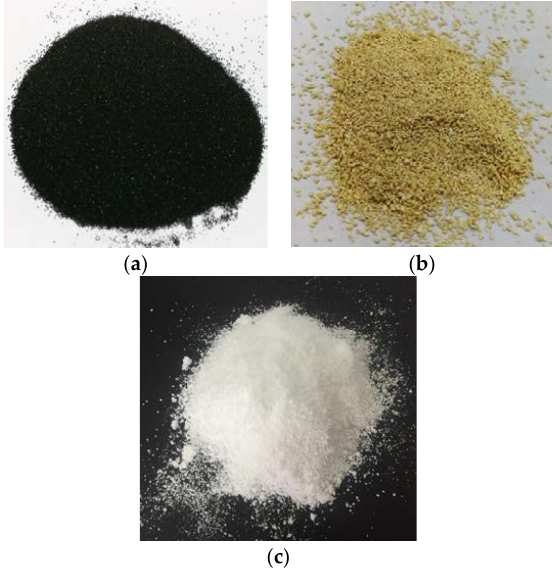
Figure 1. Materials: ( a ) Buton rock asphalt (BRA); ( b ) styrene–butadiene rubber (SBR); ( c ) Nano-CaCO 3 .